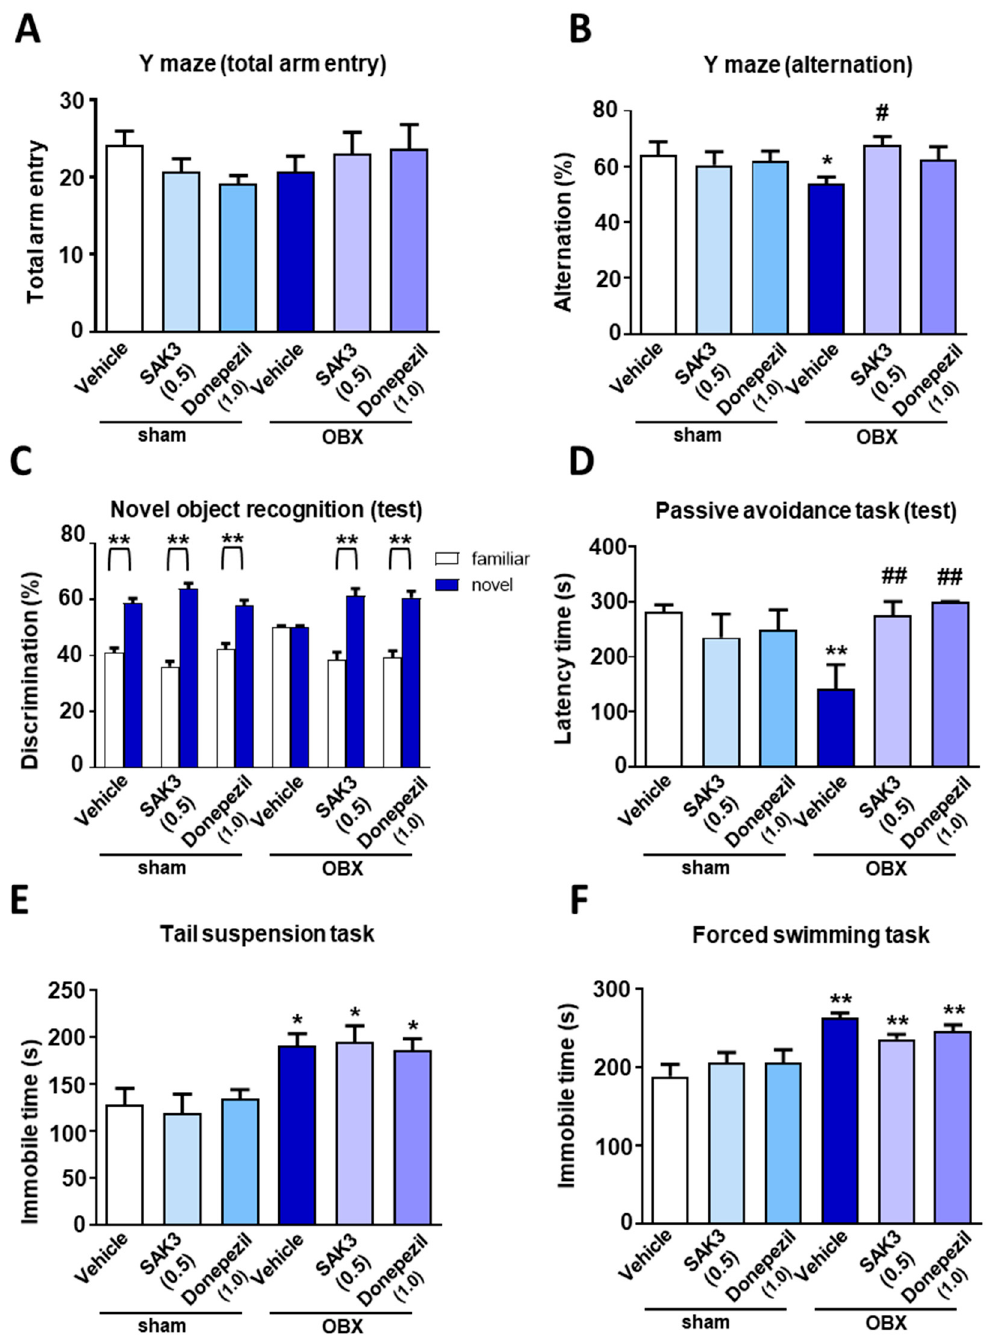
Figure 1. The effects of acute SAK3 and donepezil administration on spatial memory, cognitive functions and depressive- like behaviors in OBX mice: ( A ) Number of total arm entries and ( B ) alternations in a Y-maze task (n = 10 per group). Discrimination index of object exploration during ( C ) the test session in a novel object recognition task (n = 10 per group). Latency times before entering into the dark compartment from the light compartment during ( D ) the test session in a passive avoidance task (n = 10 per group). The reduction in immobility time between sham and OBX mice are presented in the TST ( E ) and FST ( F ) but no difference was observed between sham and OBX mice after acute SAK3 and donepezil administration (n = 10 per group). Error bars represent standard error of mean. * p < 0.05 vs. vehicle-treated sham mice; # p < 0.05 vs. vehicle-treated OBX mice, ** p < 0.01 vs. the familiar group by Student’s t -test; ** p < 0.01 vs. vehicle-treated shame mice; ## p < 0.01 vs. vehicle-treated sham mice.